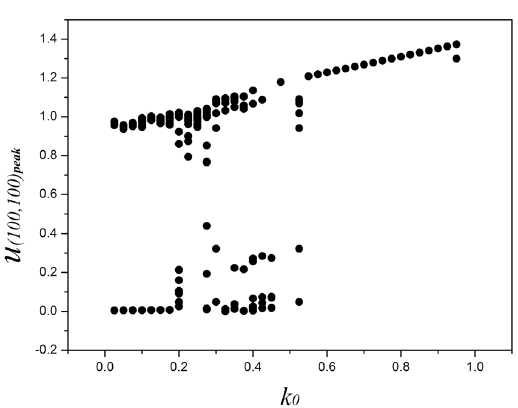
Figure 1. The time series of membrane potential are detected from the node (100,100) under different gains k 0 at k